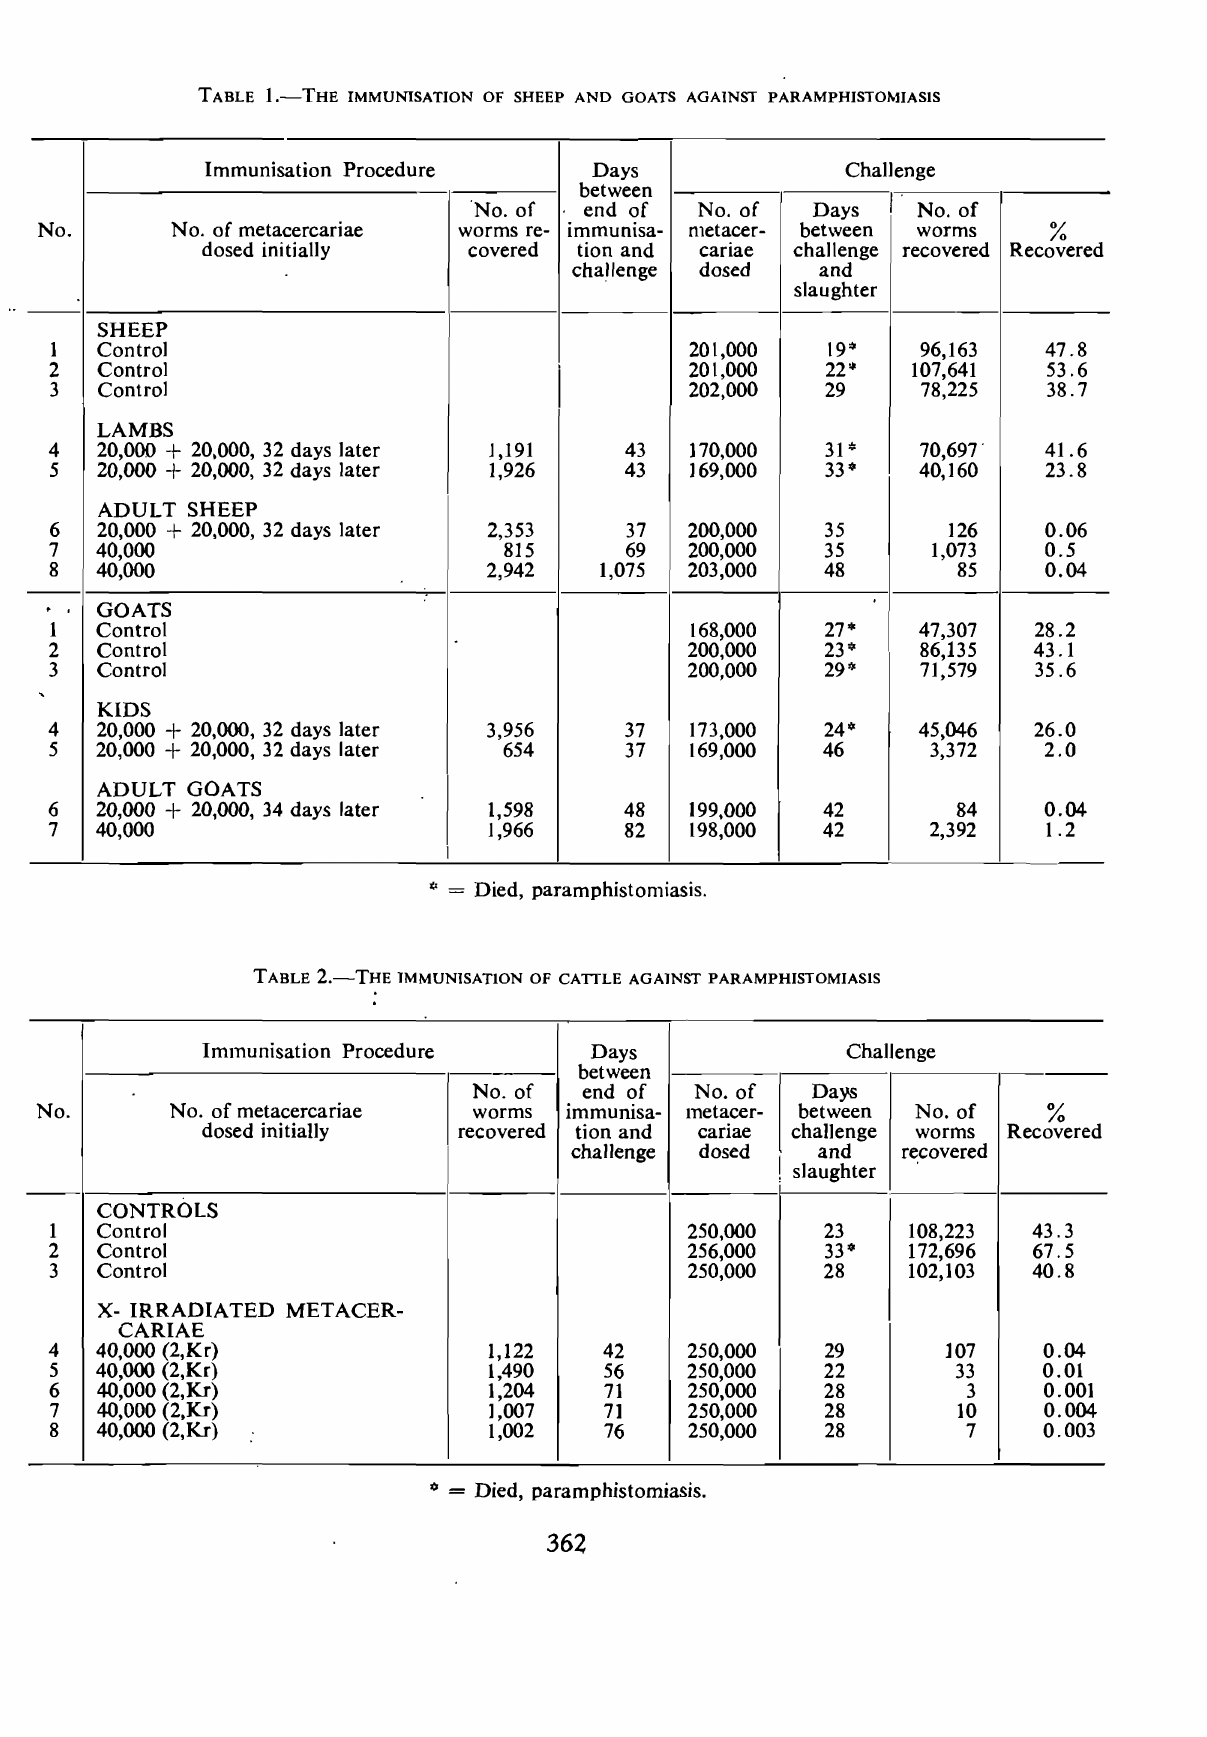
Immunisation Procedure